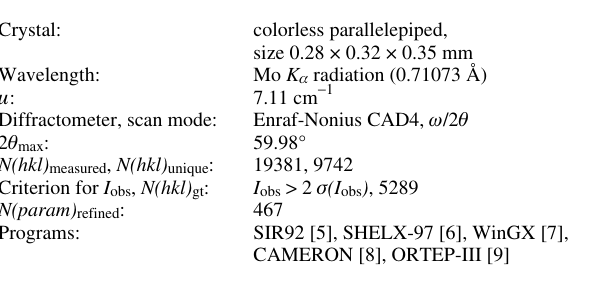
Table 1. Data collection and